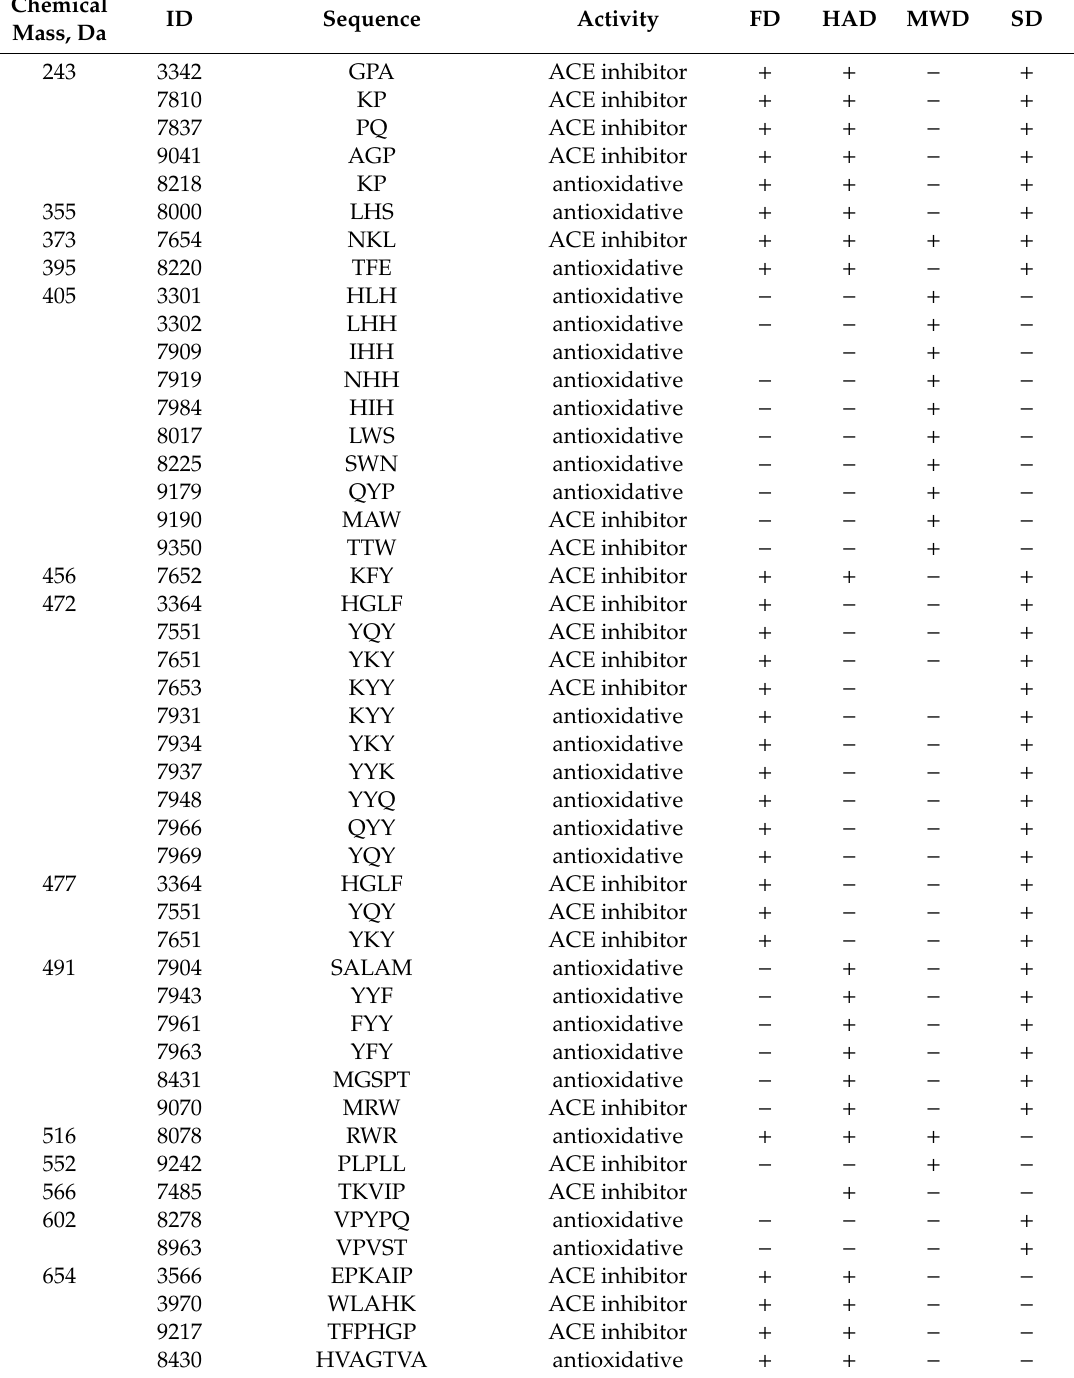
Table 4. Characterization of the peptide profile of the dry fruit bodies of Pleurotus ostreatus after in vitro digestion (in accordance with the BIOPEP